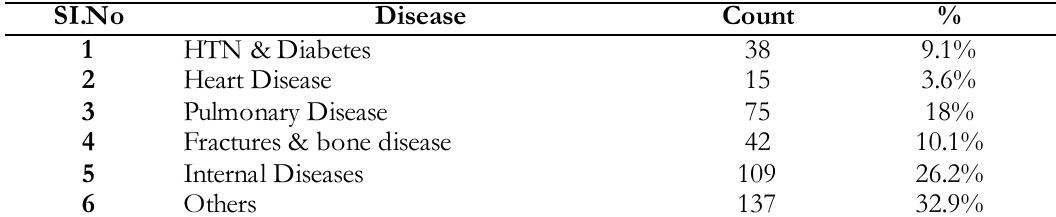
Tabel I. Patient Characteristics Table: 1 Diseases among the participants' patients in Aseer region SI.No